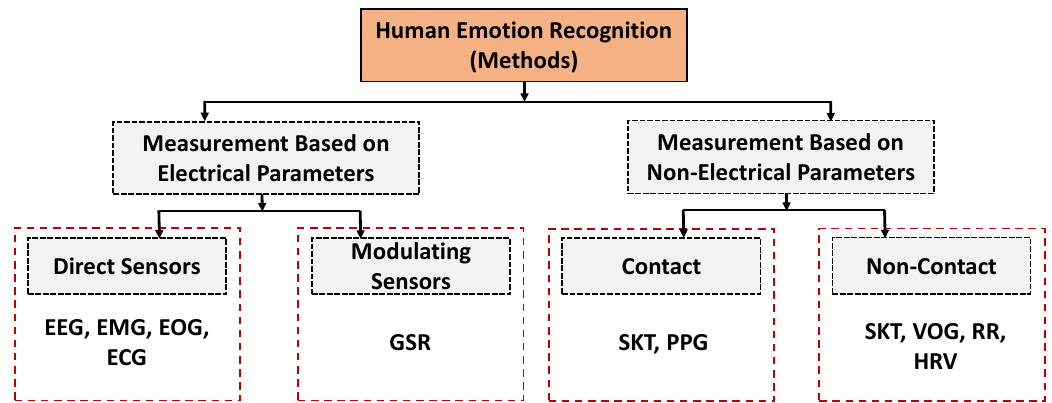
Figure 3. A taxonomy of different types of sensors based on the techniques, interaction, and physiological